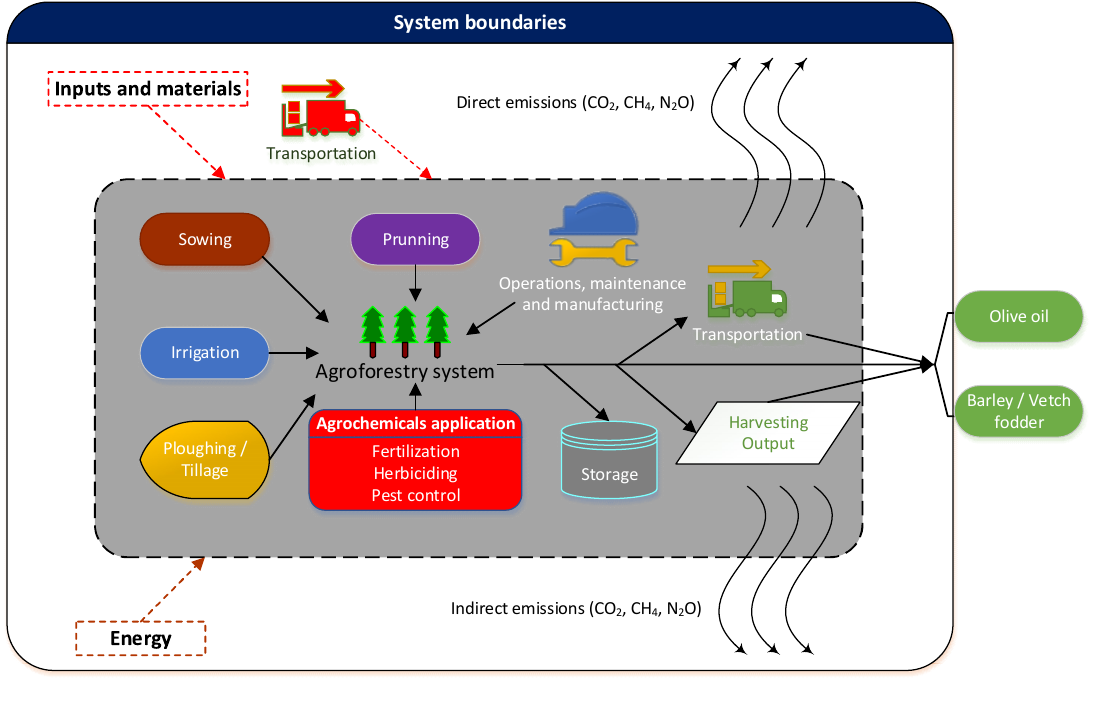
Figure 1. System boundaries. Table 1. Inventory analysis for primary energy usage and GHG